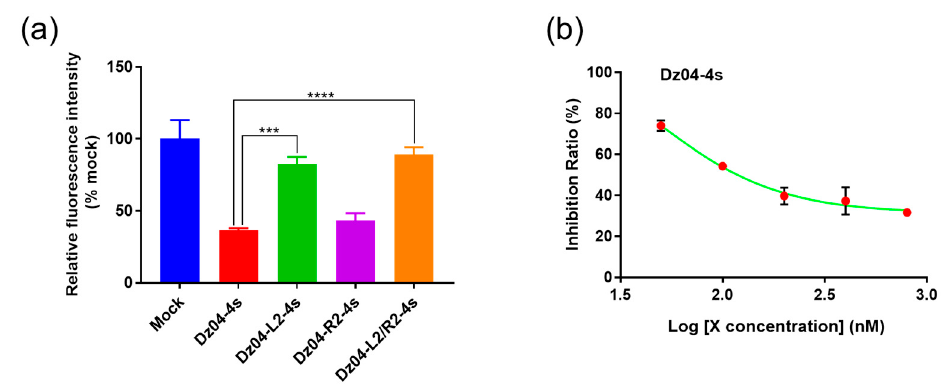
Figure 3. Identification the DNAzyme (Dz04) gene-silencing activity in cells. ( a ) The mismatched arm sequences of Dz04 compromised the EGFP gene silencing, and the data significance was determined by a Student’s t -test (*** p < 0.001, **** p < 0.0001); Each DNAzyme and mock control were labeled with different colors. ( b ) The gene-silencing activities of Dz04 at different concentrations.